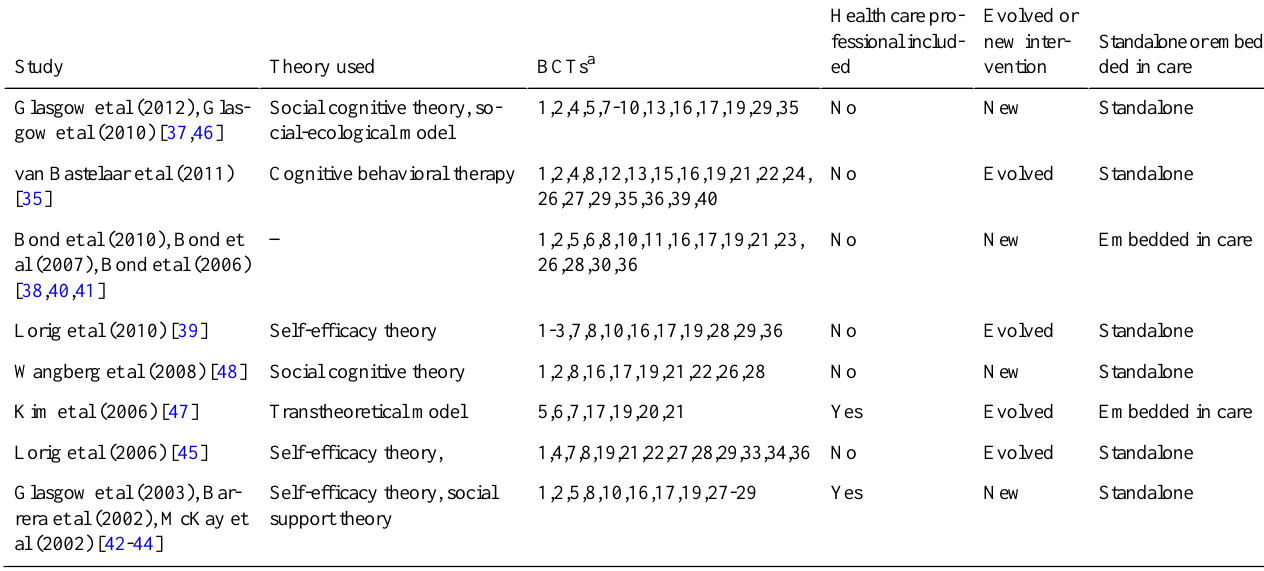
Table 4. Characteristics of the intervention programs.